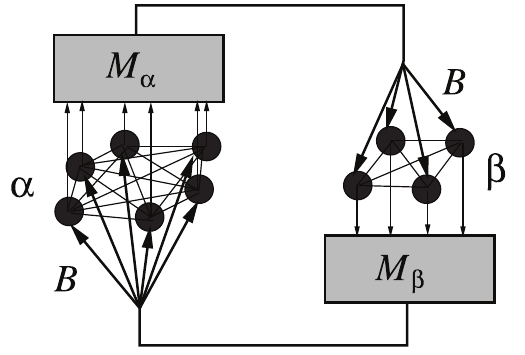
Figure 1. Representation of two populations a and b interact- ing through their reciprocal global fields M a and M b , each acting with intensity B .